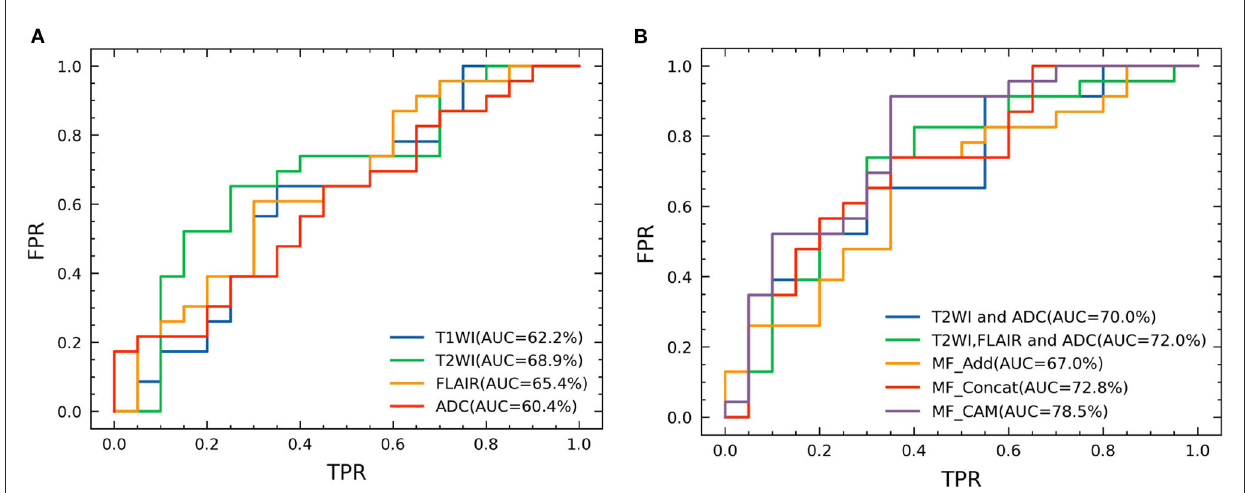
FIGURE4 ROC curves of our network and compared methods. (A) Single modality and (B) Multi modality fusion.